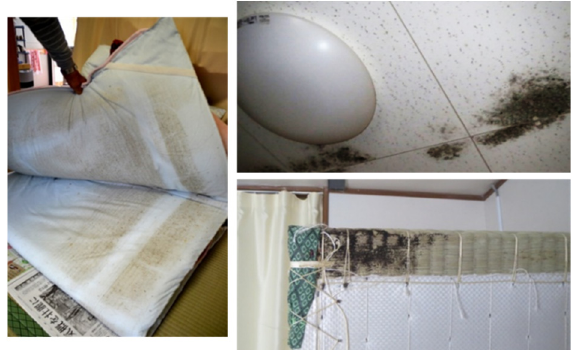
Figure 3. Fungal contamination in temporary